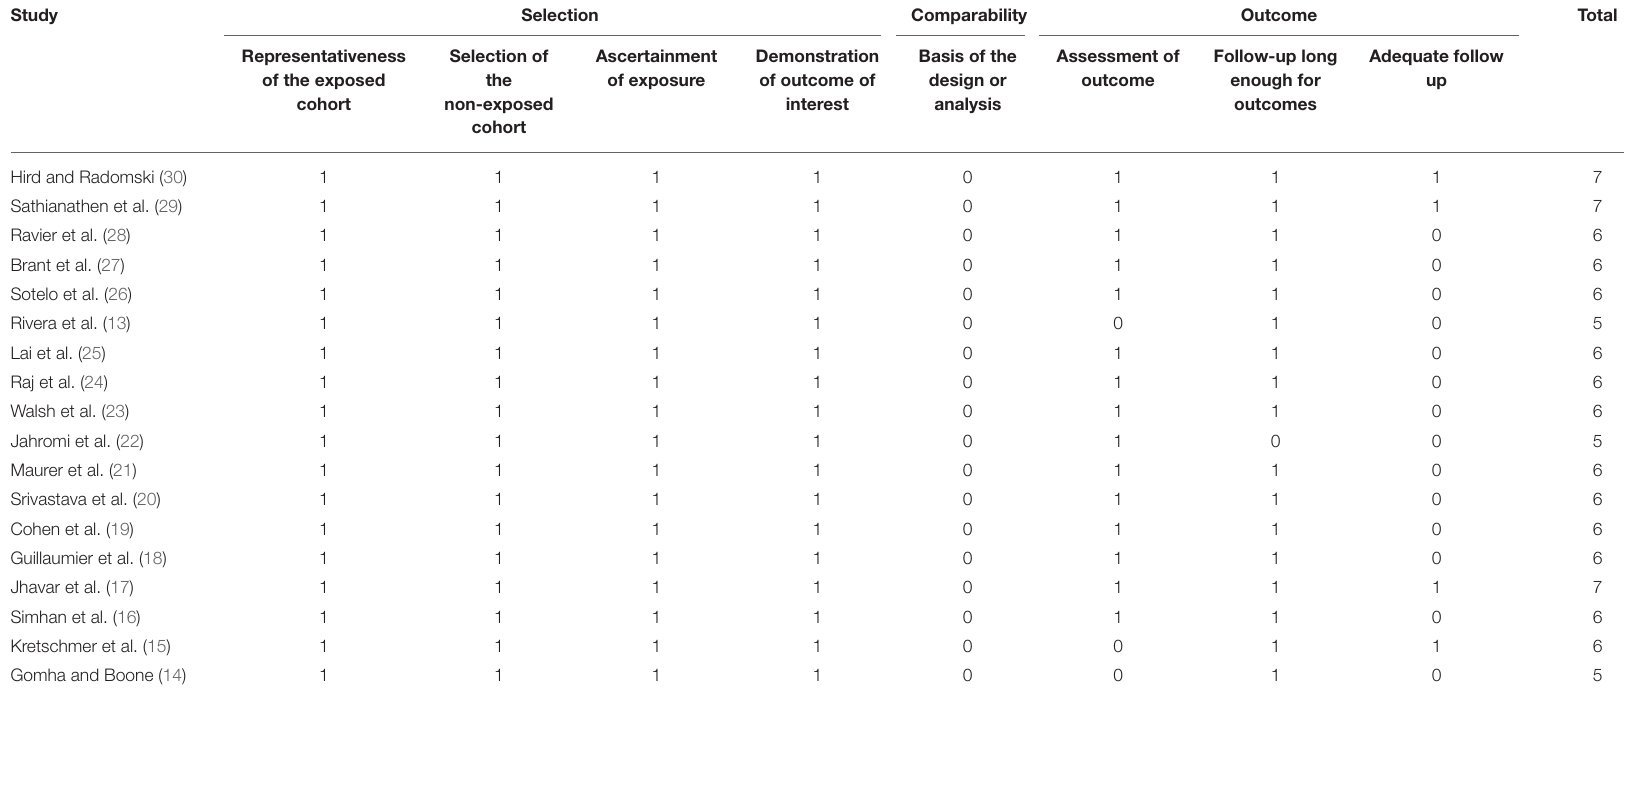
TABLE 3 | Risk of bias analysis based on Newcastle-Ottawa